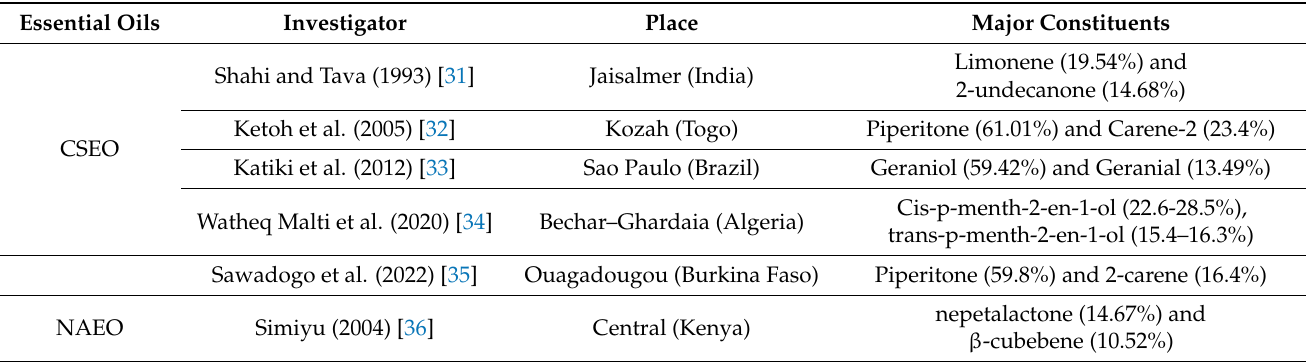
Table 7. Investigation on the chemical compositions of CSEO and NAEO.